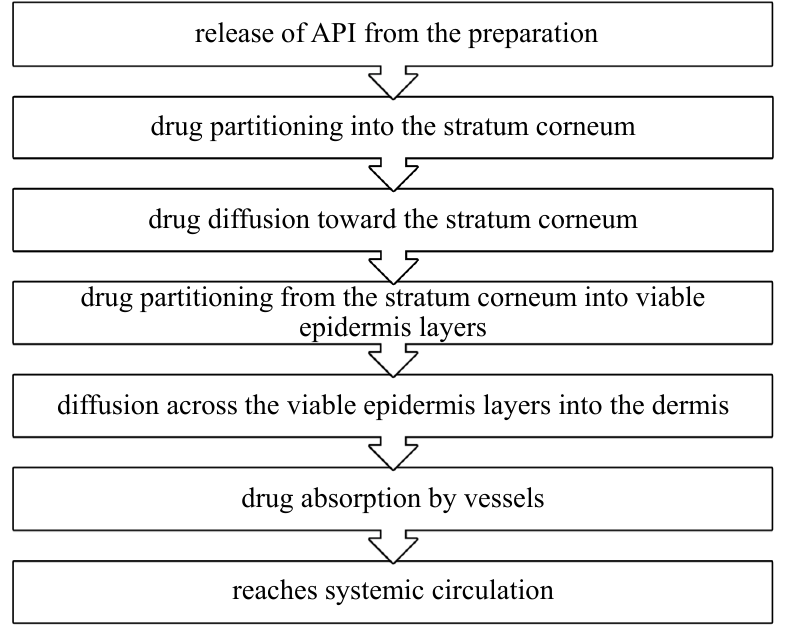
Figure 3. Drug transport across the skin.